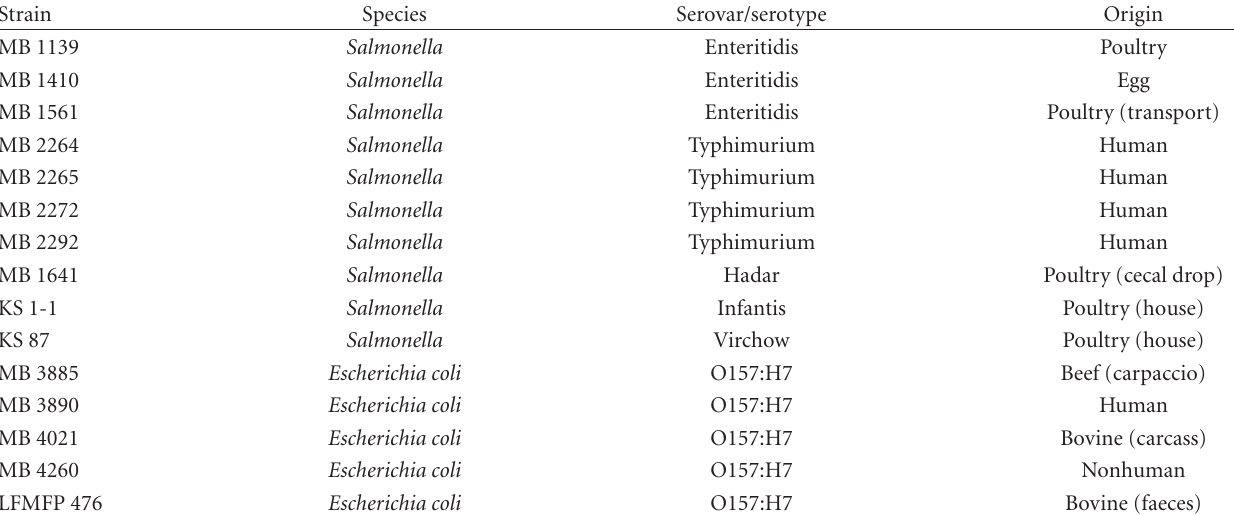
Table 1: Overview of the recipient strains.